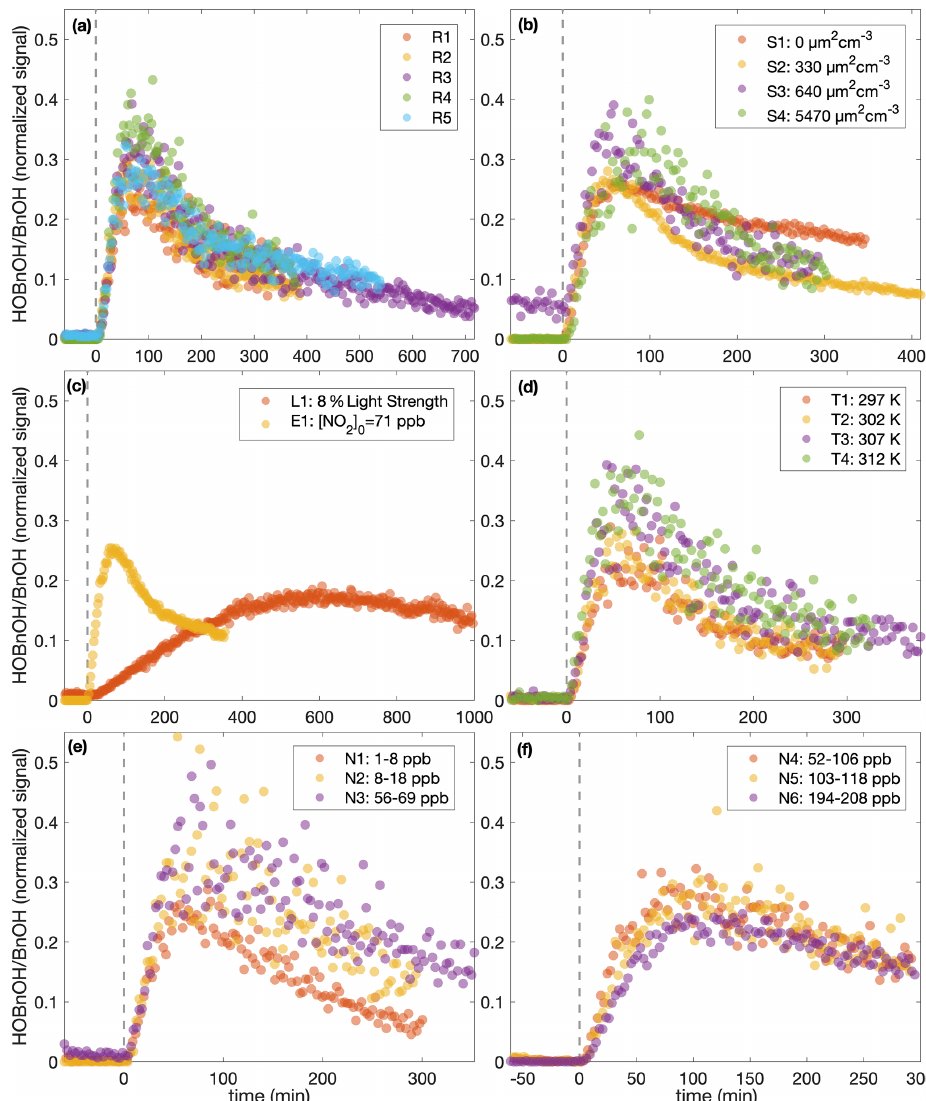
Figure 8. The normalized hydroxybenzyl alcohol (HOBnOH) signal divided by the initial normalized benzyl alcohol signal (as calculated during the background collection period) for (a) similar experiments (R1–R5), (b) different initial surface experiments (S1–S4), (c) the low- light strength experiment (L1) and the initial NO 2 experiment (E1), (d) different temperature experiments (T1–T4), (e) low constant NO mixing ratio experiments (N1–N3), and (f) high constant NO mixing ratio experiments (N4–N6). The horizontal axis indicates the time from the beginning of oxidation. For all except experiment L1, the light strength was identical. Note that the random error in the initial benzyl alcohol mixing ratio is on the order of